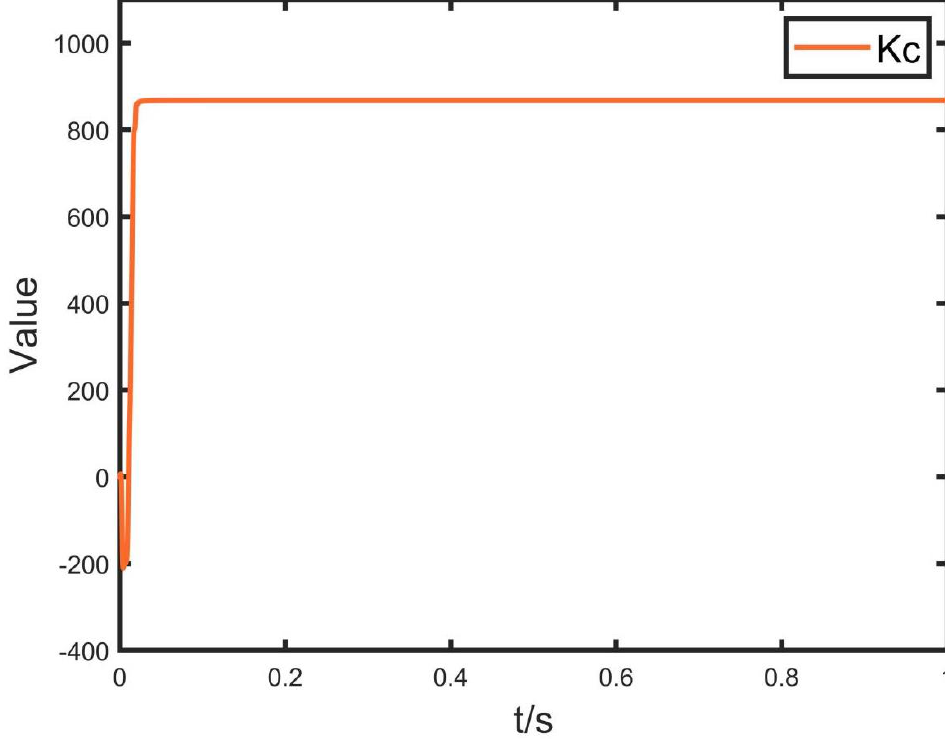
k under local shadow. Figure 12. Adaptive adjustment curve of k c under local shadow. c